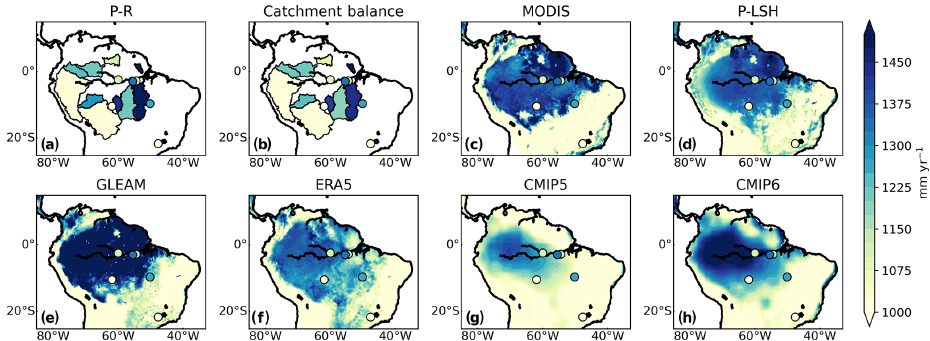
Figure 3. Spatial variation in Amazon evapotranspiration (ET) from different approaches. Climatological mean annual ET from (a) dif- ferencing precipitation and runoff, (b) catchment-balance analysis accounting for change in groundwater storage, (c–e) satellite-based ET products, (f) ERA5 reanalysis, and (g, h) climate models. The coloured circles in each panel indicate ET measured at six flux tower sites. In areas where there were multiple tower sites in close proximity, circles were plotted with an offset of 0.5 ◦ to improve data visualisation. Data for panels (a–f) and (h) are from 2003 to 2013, data for panel (g) are from 1994 to 2004, and flux tower data are from the periods shown in Table S3. Data in panels (c–h) are plotted as contour maps with contours at 25mm intervals from 1000 to 1500mmyr − 1 . GLEAM data are presented with an alternative scale in Fig.